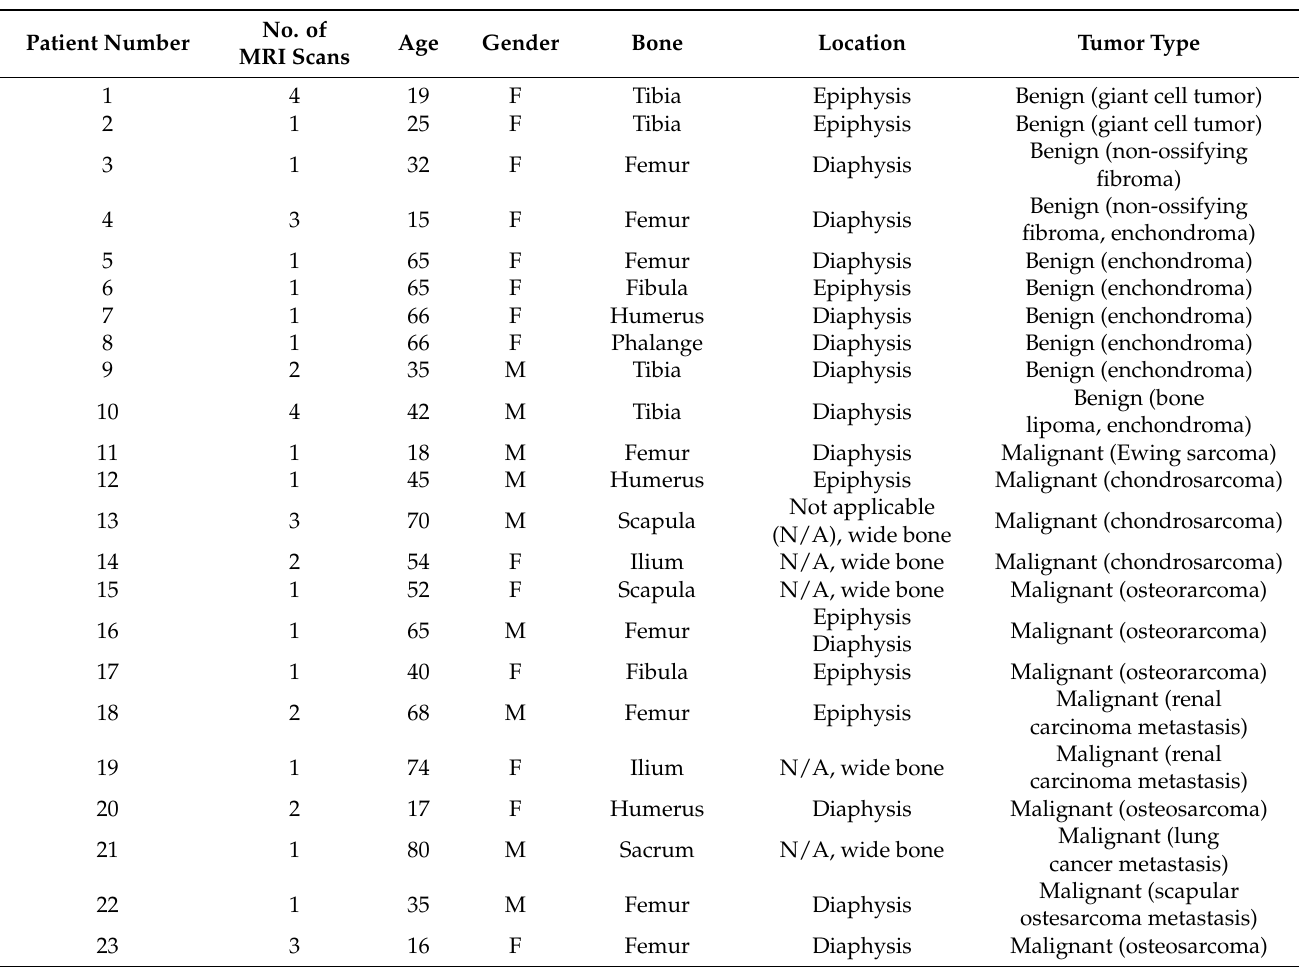
Table 1. Dataset detailed